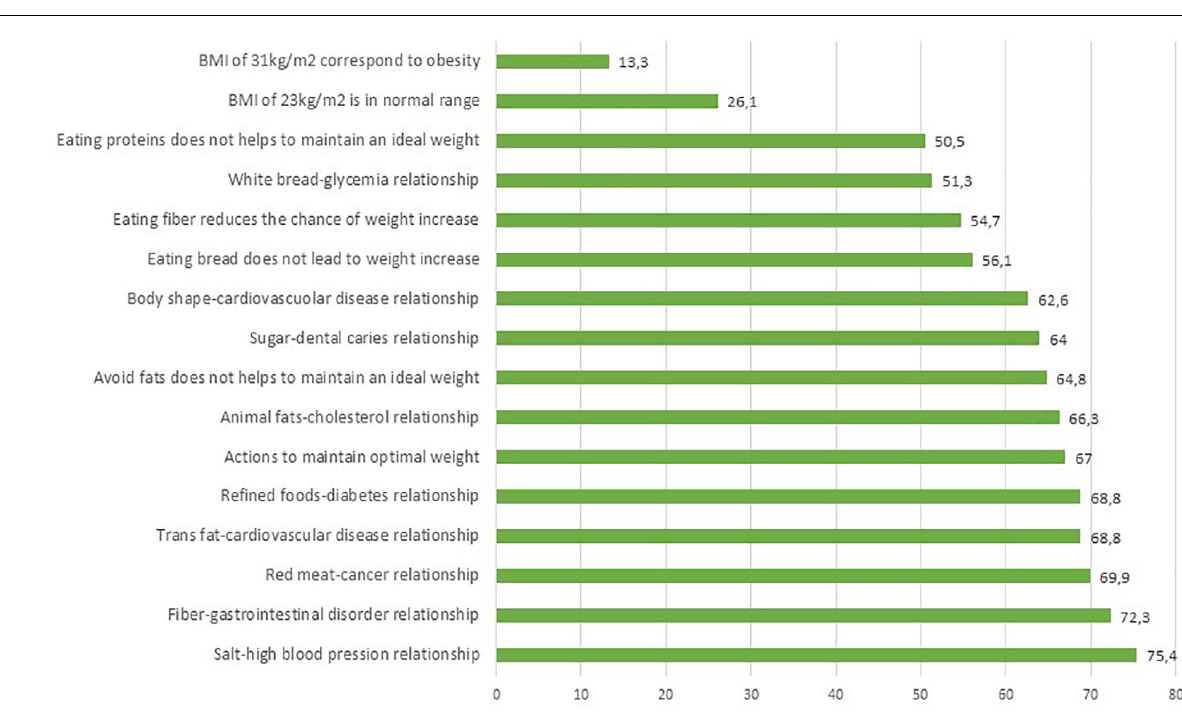
FIGURE 4 | Percentages of correct answers of the NK4–diet-diseases associations